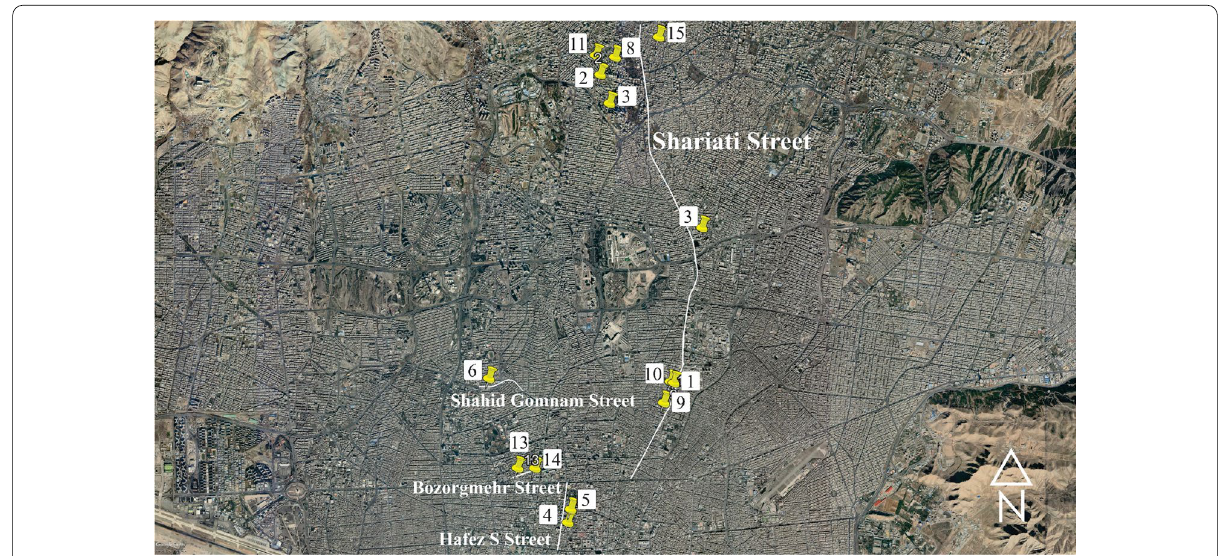
Fig. 5 The locations of selected façade buildings in